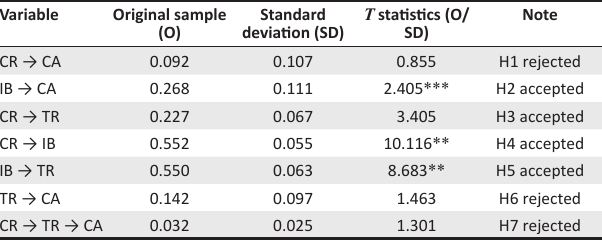
TABLE 2: Original sample, standard deviation, T -values.